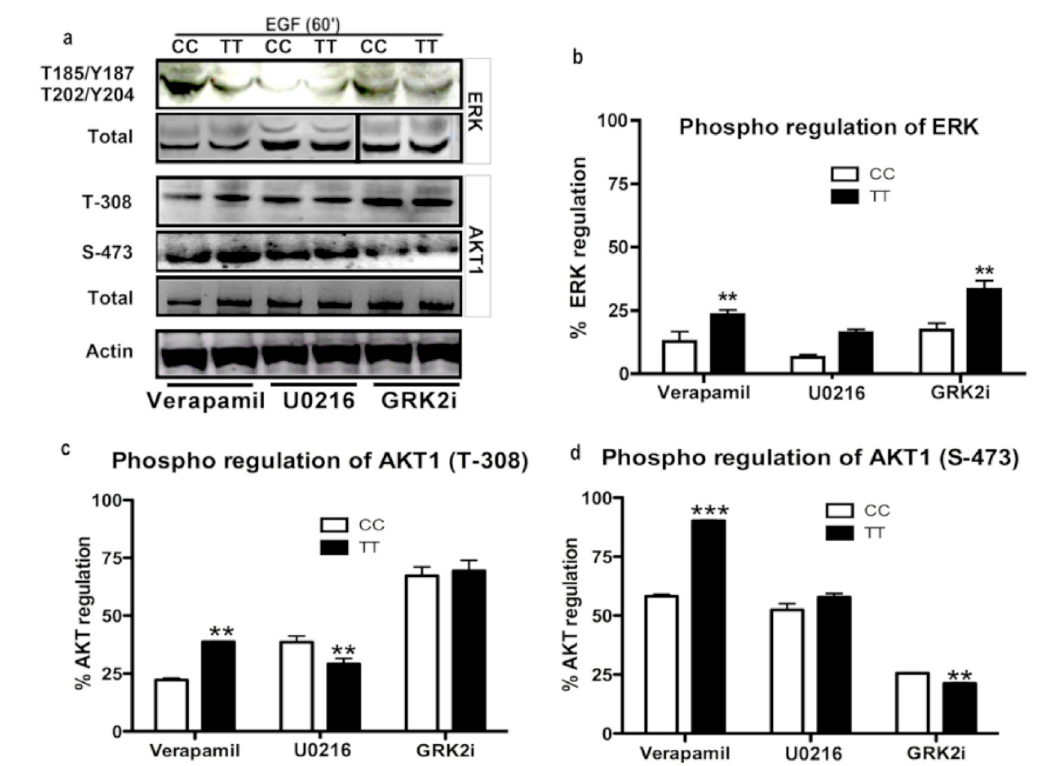
Figure 10. The presence of Gβ3s causes altered ERK and AKT signaling response to growth inhibitory treatments: TT and CC lymphoblasts were exposed individually to calcium ion channel blocker Verapamil, G bg signaling inhibitor GRK2i, and MEK inhibitor U0216 to study the effects of such treatments on their EGF induced phospho ERK and AKT1 signaling profiles. While EGF induced ERK phosphorylation was disrupted in TT lymphoblasts following treatments with any of the inhibitors with most inhibition achieved following MEK inhibition (a & b), phospho AKT1 Serine 473 levels were found to be enhanced upon verapamil treatment in TT cells as compared to CC counterparts (d). Distinct responses to inhibitor treatments as exhibited by TT and CC lymphoblasts are confirmed by semi quantitative densitometry analyses. Data presented in all panels are the mean with standard error (bars) of n = 3 independent experiments. Statistical significance is shown as *P<0.05, **P<0.01, ***P<0.001.